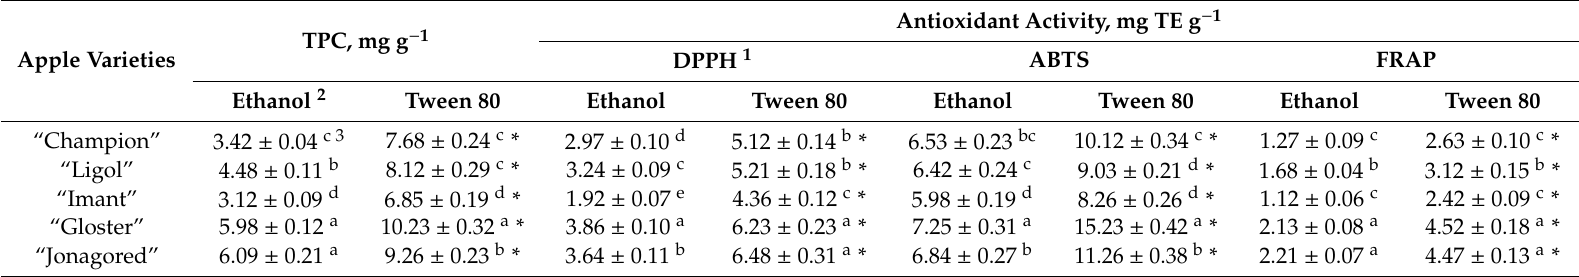
Table 5. Total phenolic content and antioxidant activity of optimized extracts of pomace from di ff erent apple varieties